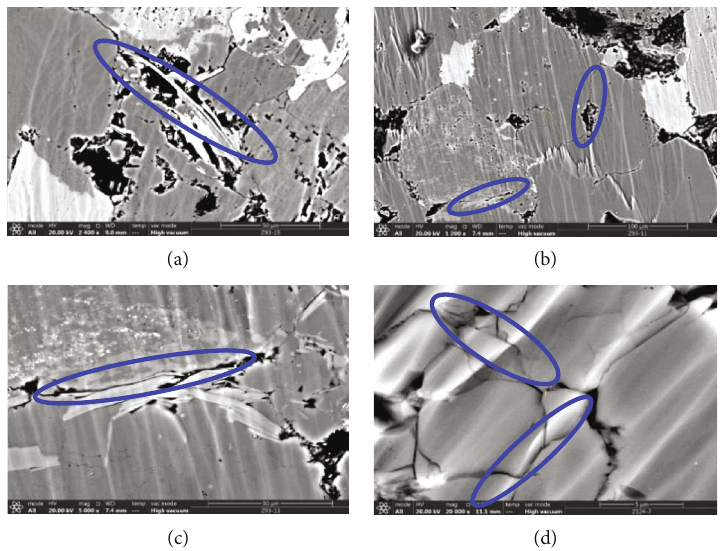
Figure 8: Three-beam argon ion etching polished FIB-SEM